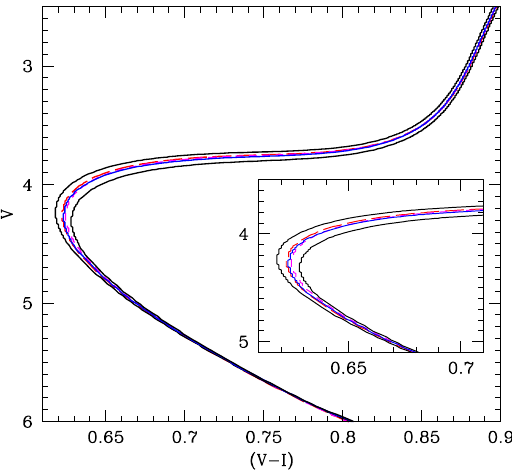
Figure 2. As Figure 1 but for the ( V,V − I ) CMD, for two assumptions about A V .